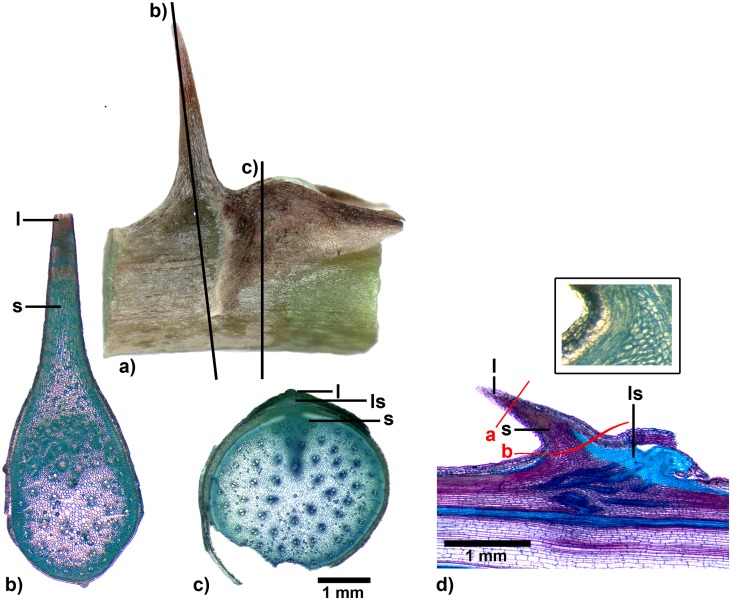
Spine of Asparagus falcatus.a) Side-view of a spine with split leaf structure and emerging axillary bud, black lines indicate section planes of cross sections b) and c), b) and c) cross sections at different planes (from different specimens) both stained with toluidine blue (box: close up from a different, unstained cut), d) longitudinal section stained with toluidine, red lines indicate modes of failure observed in the mechanical tests, a: failure of the tip, b: failure of the whole spine). l: leaf tissue, s: stem tissue, ls: lateral shoot tissue.